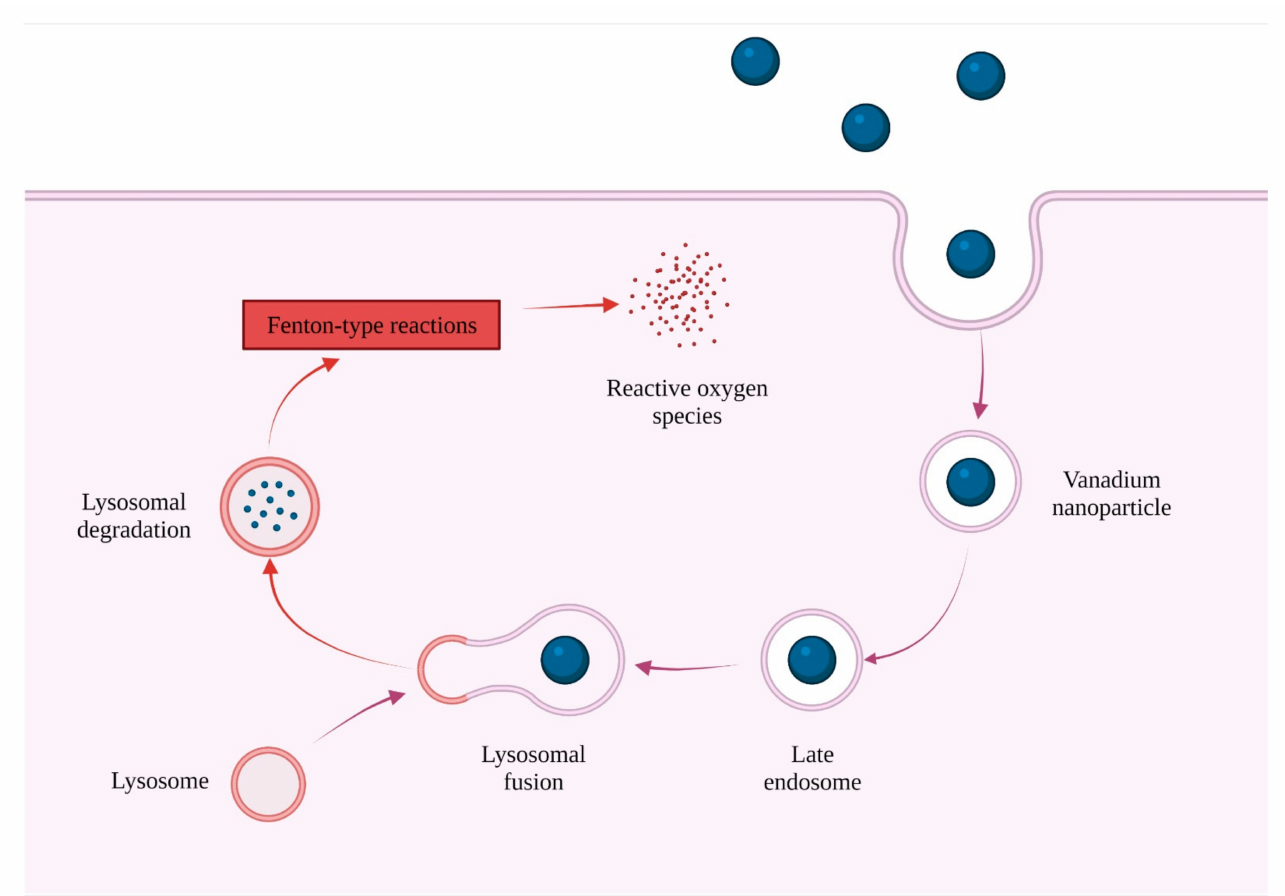
Figure 5. Interaction of vanadium nanoparticles with lysosomes (created using BioRender.com). V 2 O 5 NPs might provide a new line of approach for novel therapies for melanoma and other cancers via their antiangiogenic properties. Research conducted with V 2 O 5